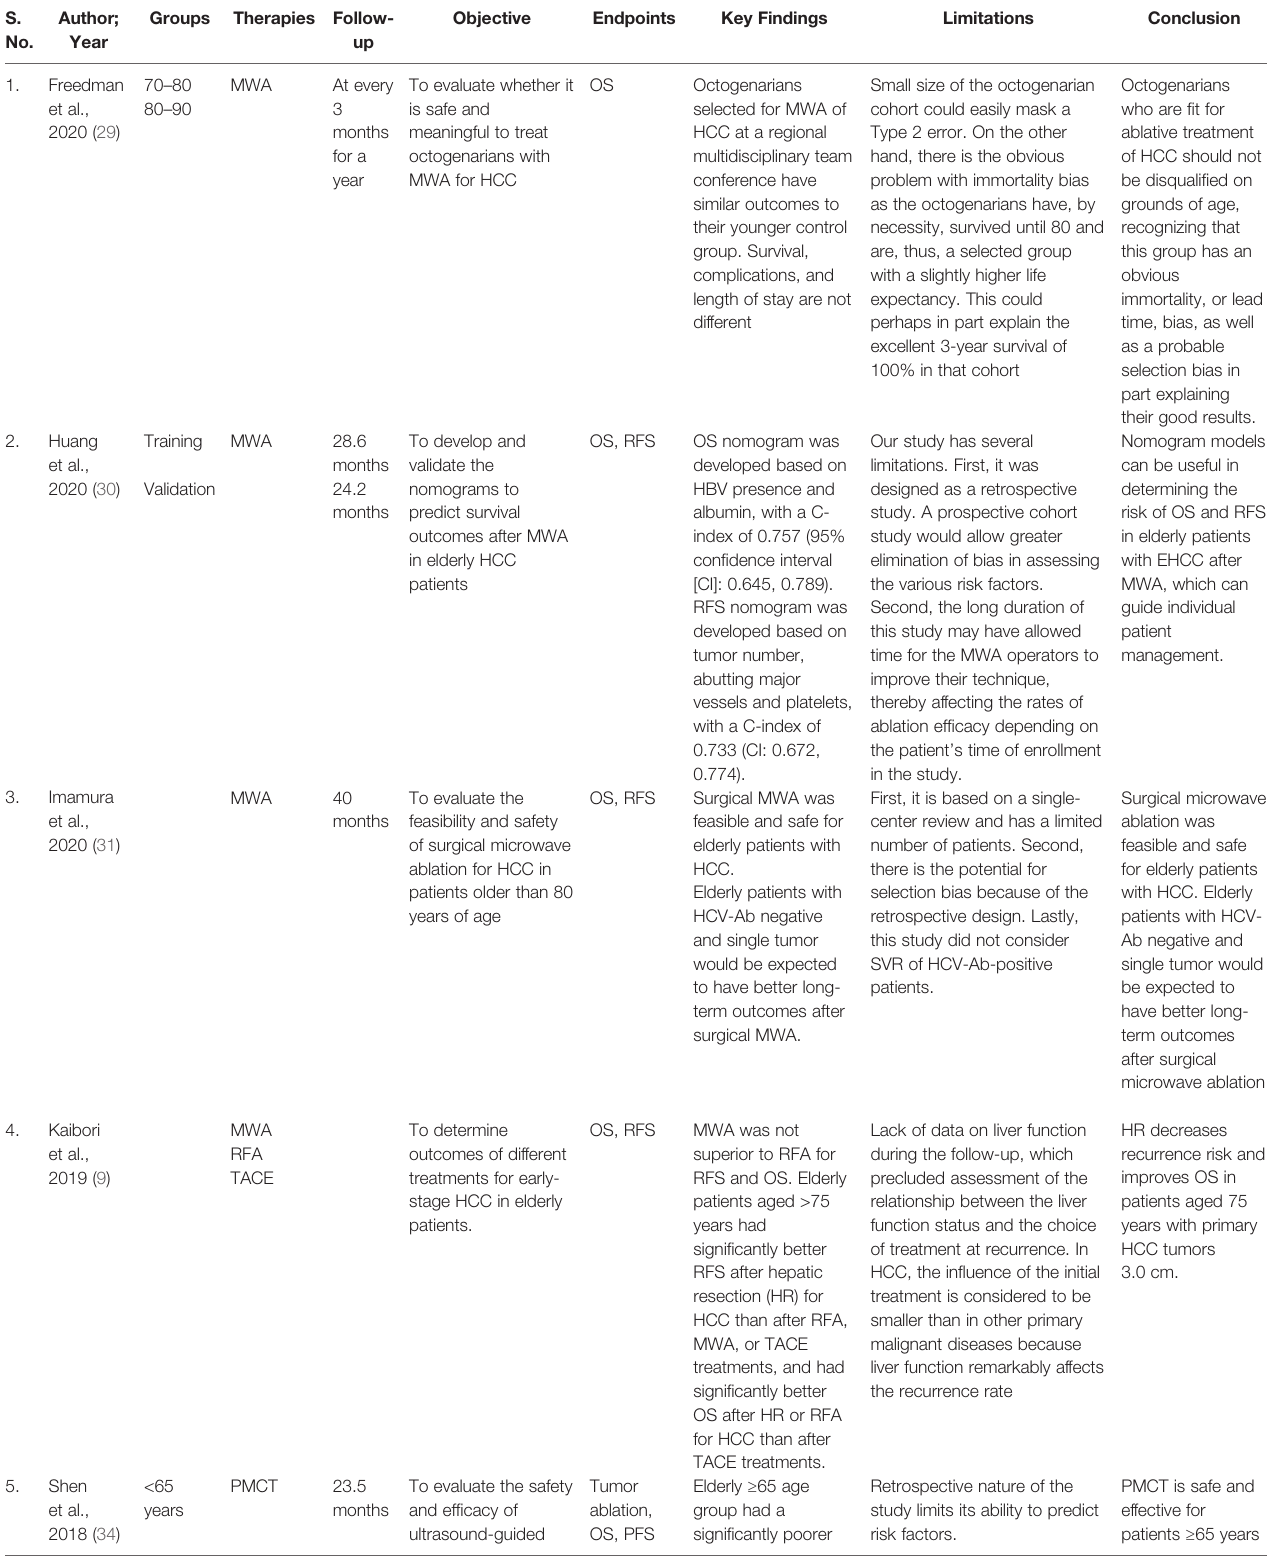
TABLE 2 | Descriptive summary of fi ndings for the included studies investigating microwave ablation for hepatocellular carcinoma in elderly patients. S.